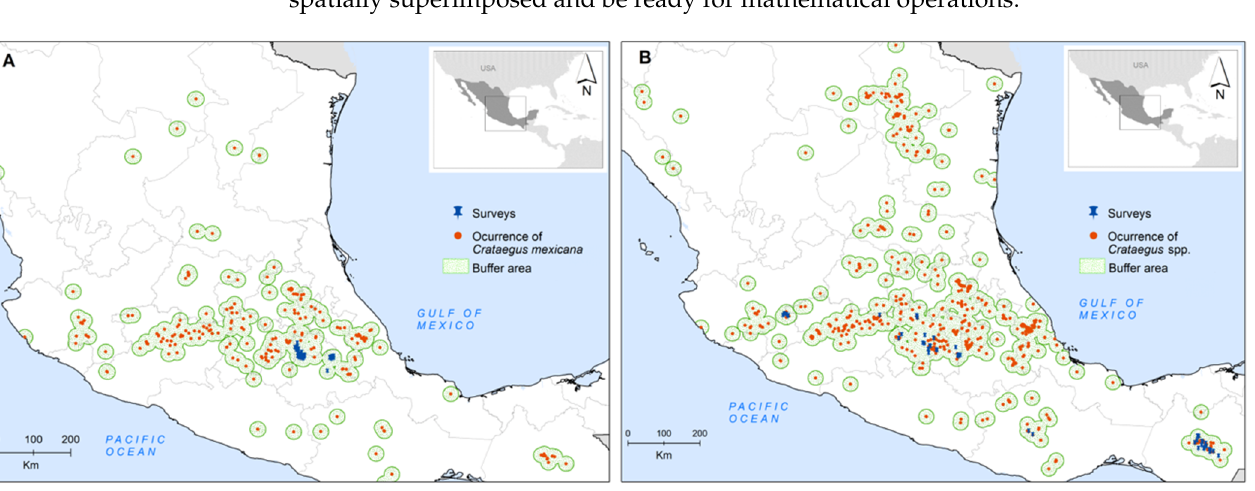
Figure 3. Geographic distribution, survey sites and working area for ( A ) cultivated and ( B ) wild hawthorn.